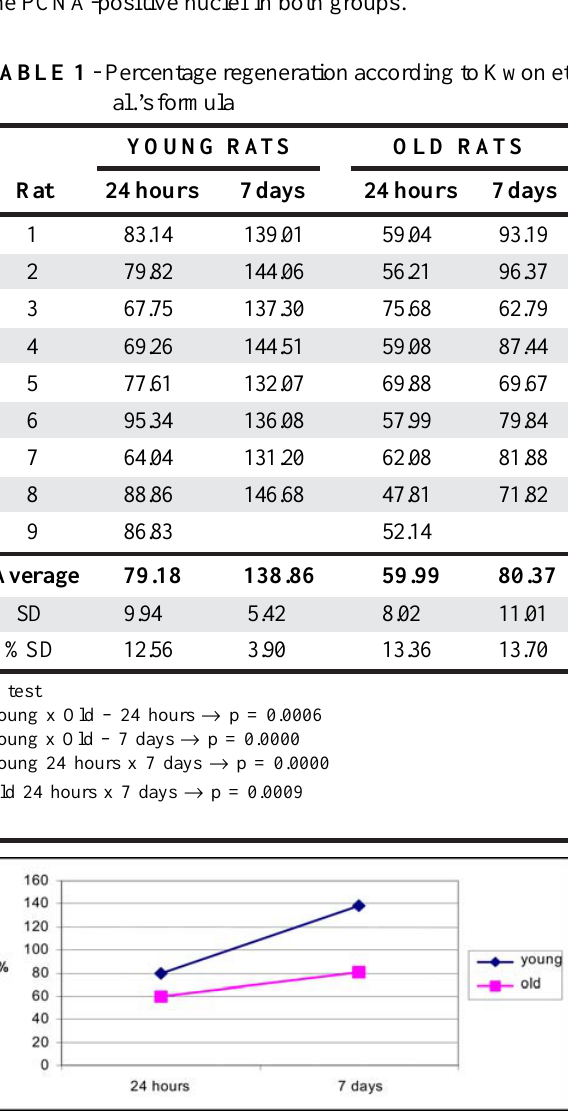
FIGURE 1 - Liver regeneration calculated according to Kwon et al.’s formula